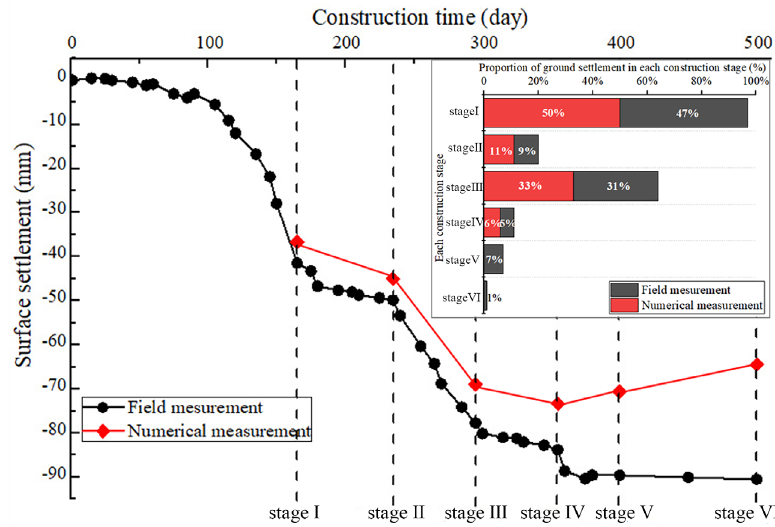
Figure 15. Variation of the surface settlement of Qinghuadongluxikou Station during the construction period.